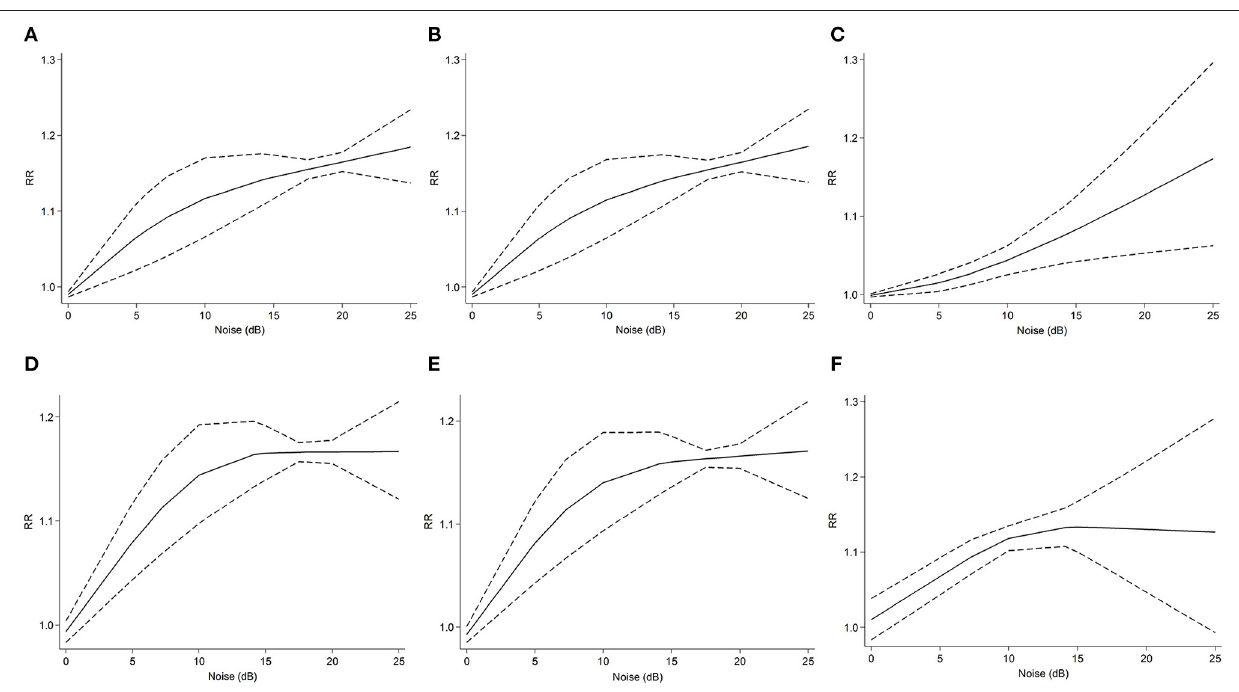
FIGURE 3 | Dose-response meta-analysis between noise exposure and risk of different types of dementia. The horizontal axis represents the noise increment, and the vertical axis represents the relative risk of noise increase to dementia. The two dashed lines represent the upper and lower limits of the 95% confidence interval for relative risk. (A) dose-response analysis of noise increment and AD risk in all studies. (B) dose-response analysis of noise increment and risk of AD and dementia in all studies. (C) dose-response analysis of noise increment and risk of VaD and NAD in all studies. (D) dose-response analysis of noise increment and AD risk in cohort studies. (E) dose-response analysis of noise increment and risk of AD and dementia in cohort. (F) dose-response analysis of noise increment and risk of VaD and NAD in cohort studies. learning and memory function in the temporal lobe (62,